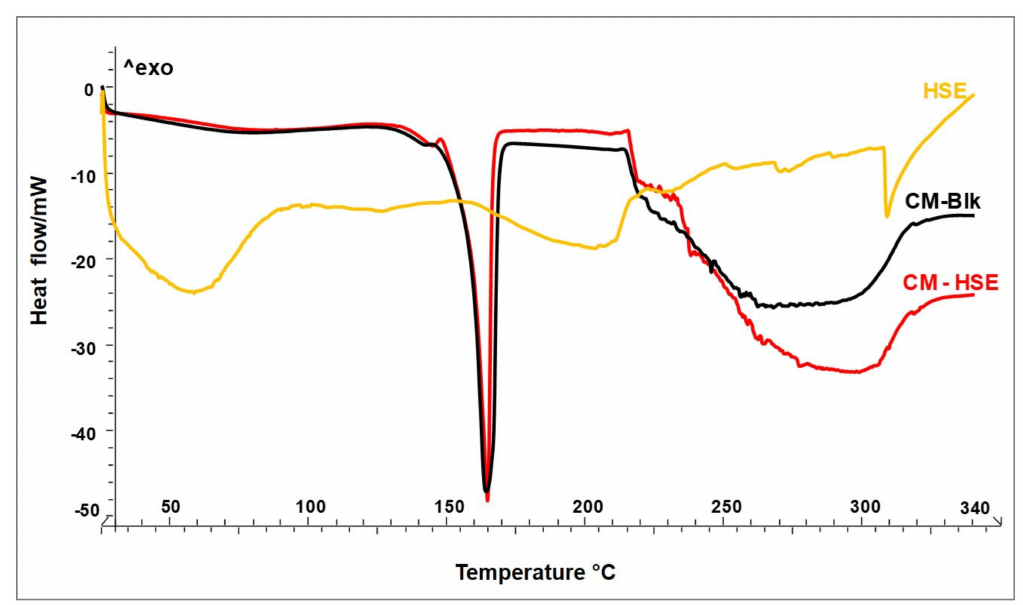
Figure 2. DSC of unloaded CM-Blk (black line) and loaded CM-HSE (red line) particle systems in comparison to HSE raw material (yellow